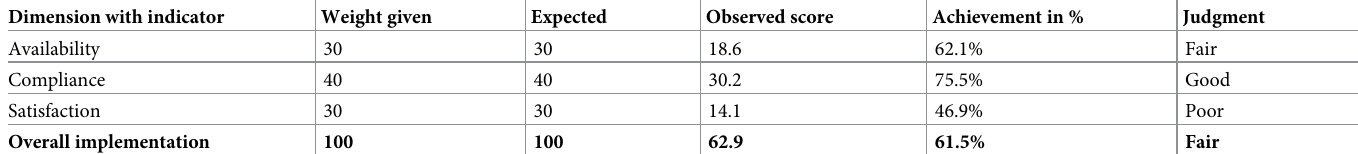
Table 7. Overall Judgment matrix and analysis for family planning program evaluation at Gondar city administrative public health facilities, Northwest Ethiopia, 2020. Dimension with